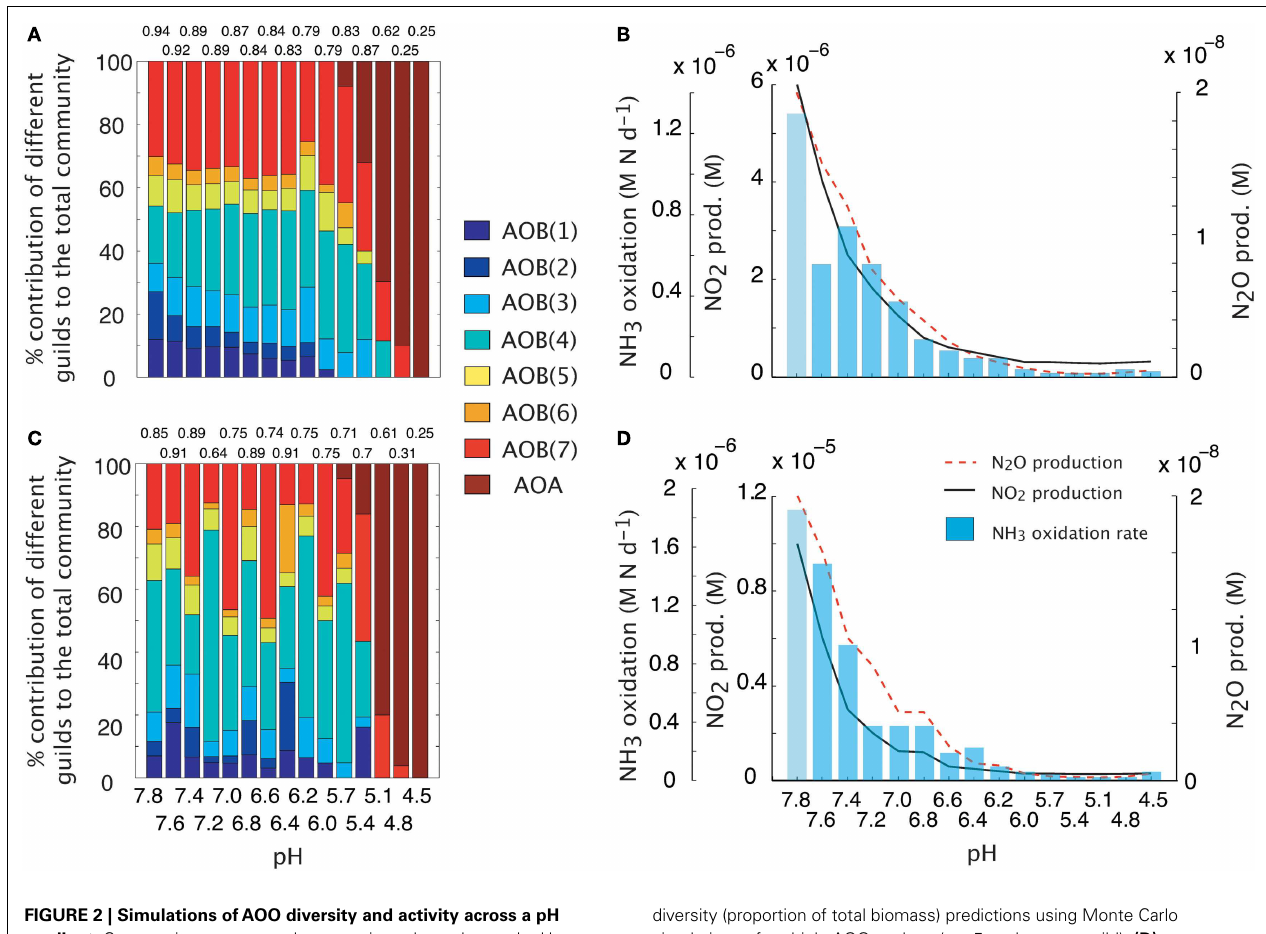
FIGURE 2 | Simulations ofAOO diversity and activity across a pH gradient. Community evenness values are given above the stacked bars. (A) Community diversity (proportion of total biomass) predictions using mean trait values. (B) Simulated nitrifier activity (NH 3 oxidation, NO 2 production, N 2 O production) using mean trait values. (C) Community